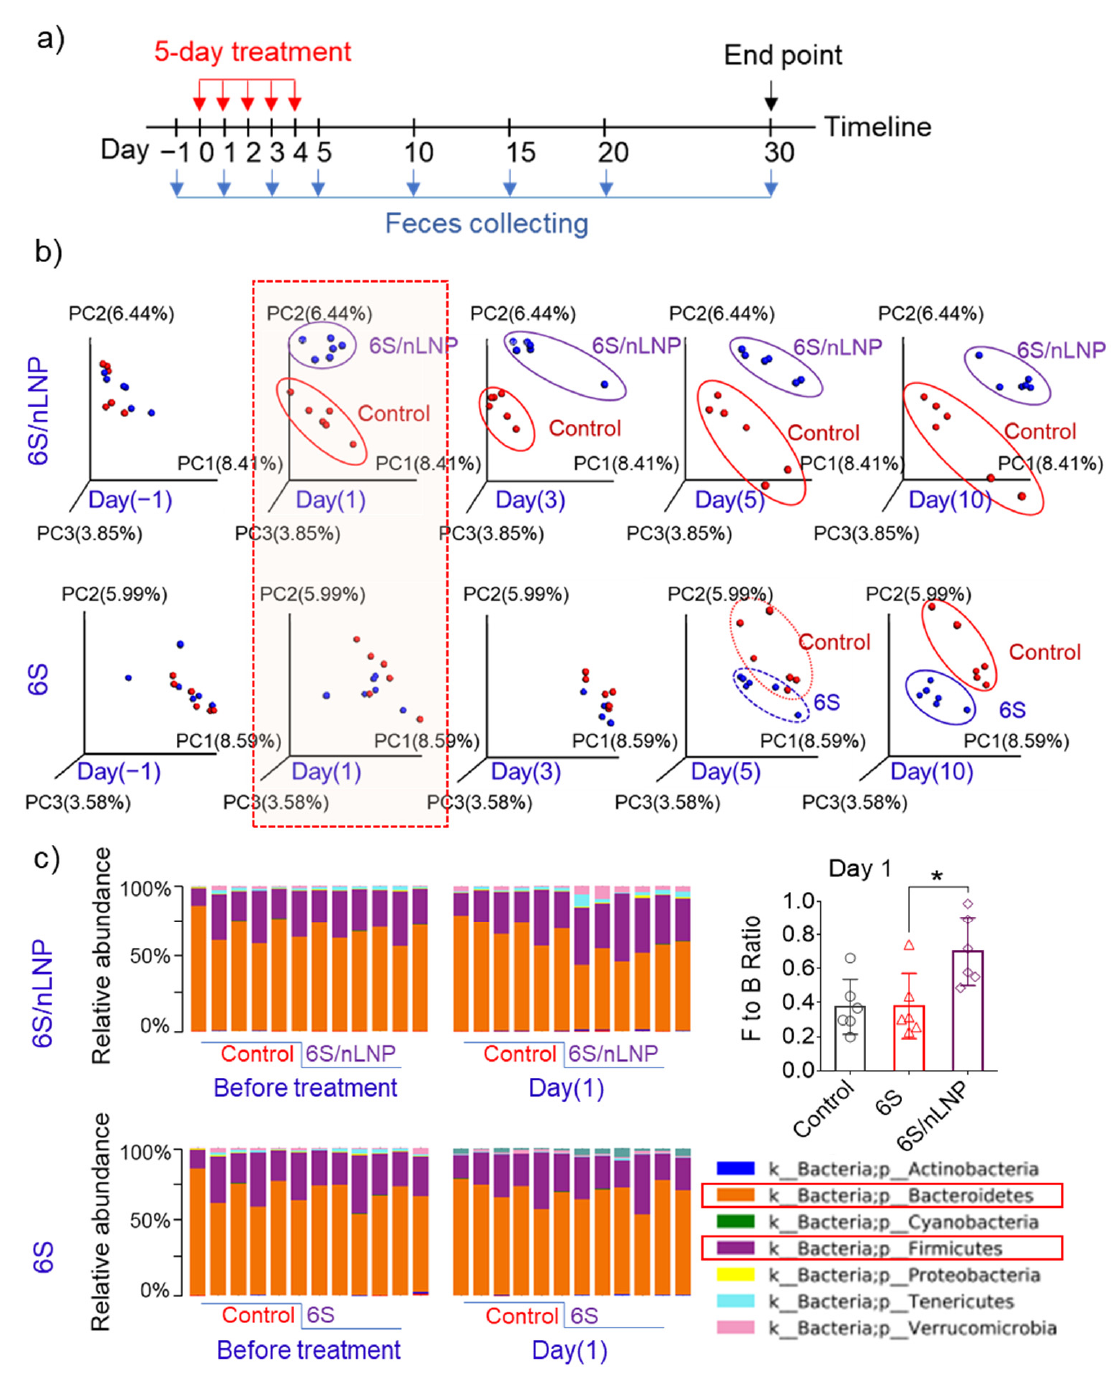
Figure 2. The onset of action of changes in microbiota composition is much faster in mice treated with 6S/nLNP than in those treated with free 6S. ( a ) Schematic diagram of treatment and feces collection. ( b ) PCoA of microbiota composition in mice treated with 6S/nLNPs or free 6S relative to a control group of mice (days − 1, 1, 3, 5, and 10). ( c ) Taxonomic summary at the phylum level and Firmicutes/Bacteroidetes (F/B) ratio of gut microbiota (day 1) with 6S/nLNP or free 6S versus control treatment ( n = 6; * p < 0.05).